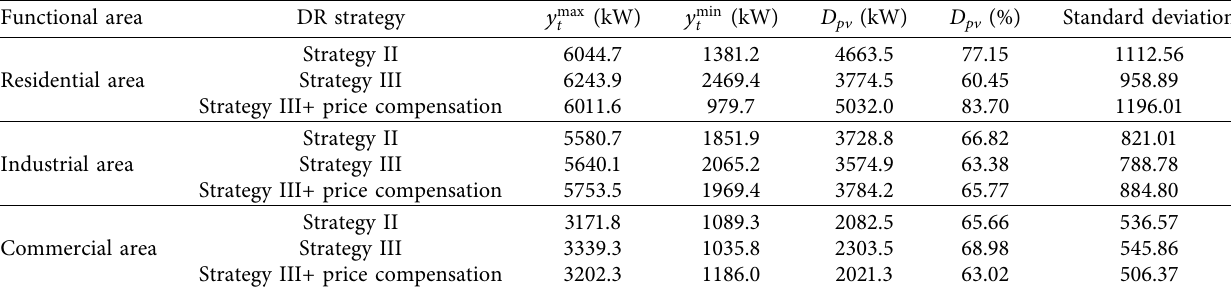
Table 6: Load optimization of each functional area under diferent DR